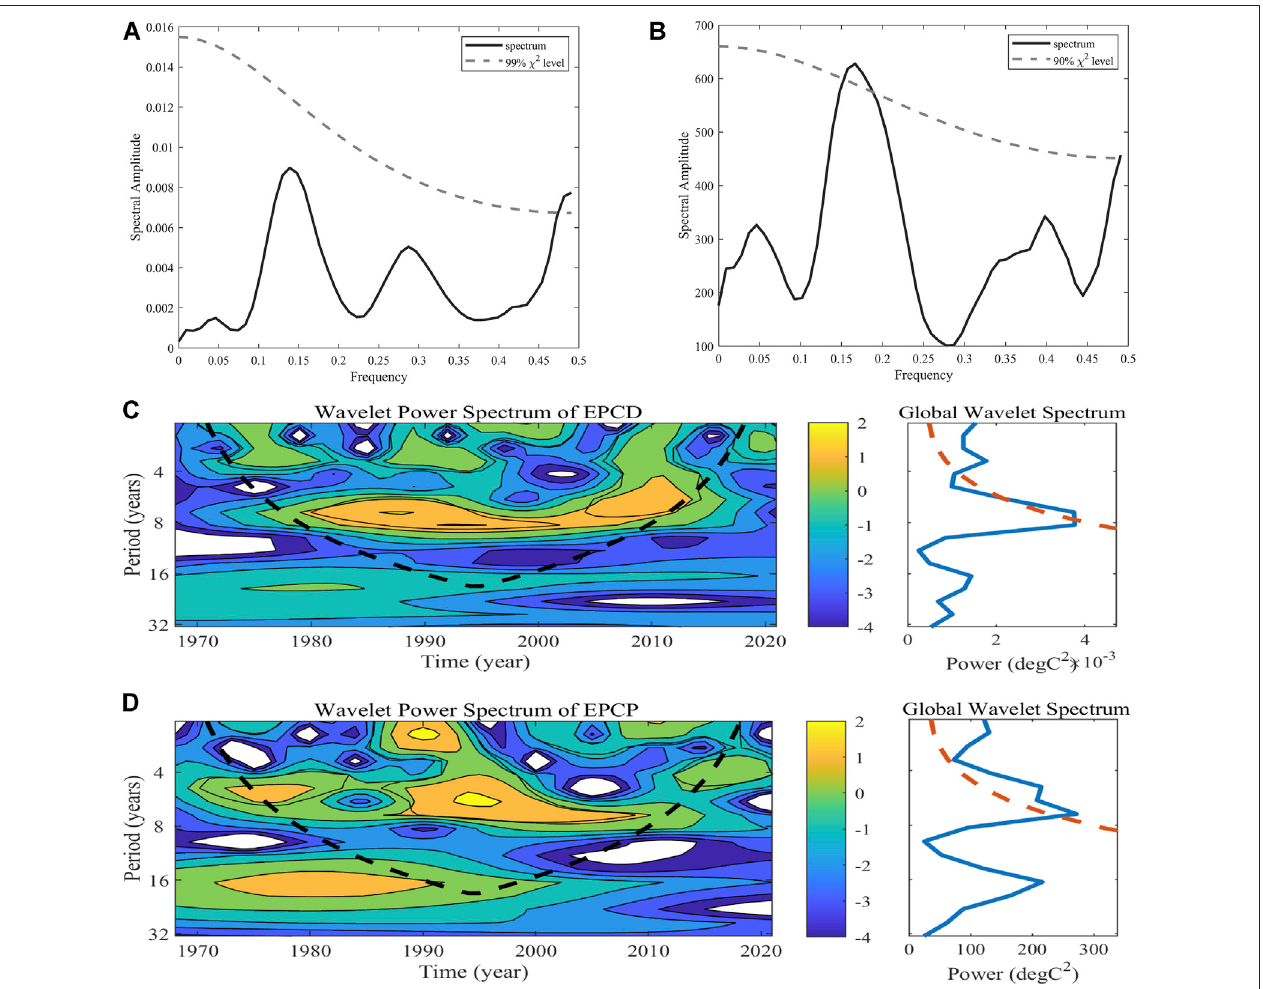
FIGURE6| Oscillationsofextremeprecipitationconcentrationdegree(EPCD)andextremeprecipitationconcentrationperiod(EPCP).Powerspectrumanalysesof (A) EPCD and (B) EPCP. Waveletpower spectrum and global wavelet spectrum of (C) EPCD and (D) EPCP. Black closed contours of the wavelet power spectrum and red dashed curve of the global wavelet spectrum designate the 95% signi fi cance level against red noise, and the cone of in fl uence where edge effects might cause distortion is shown by the U-shaped dashed curve.